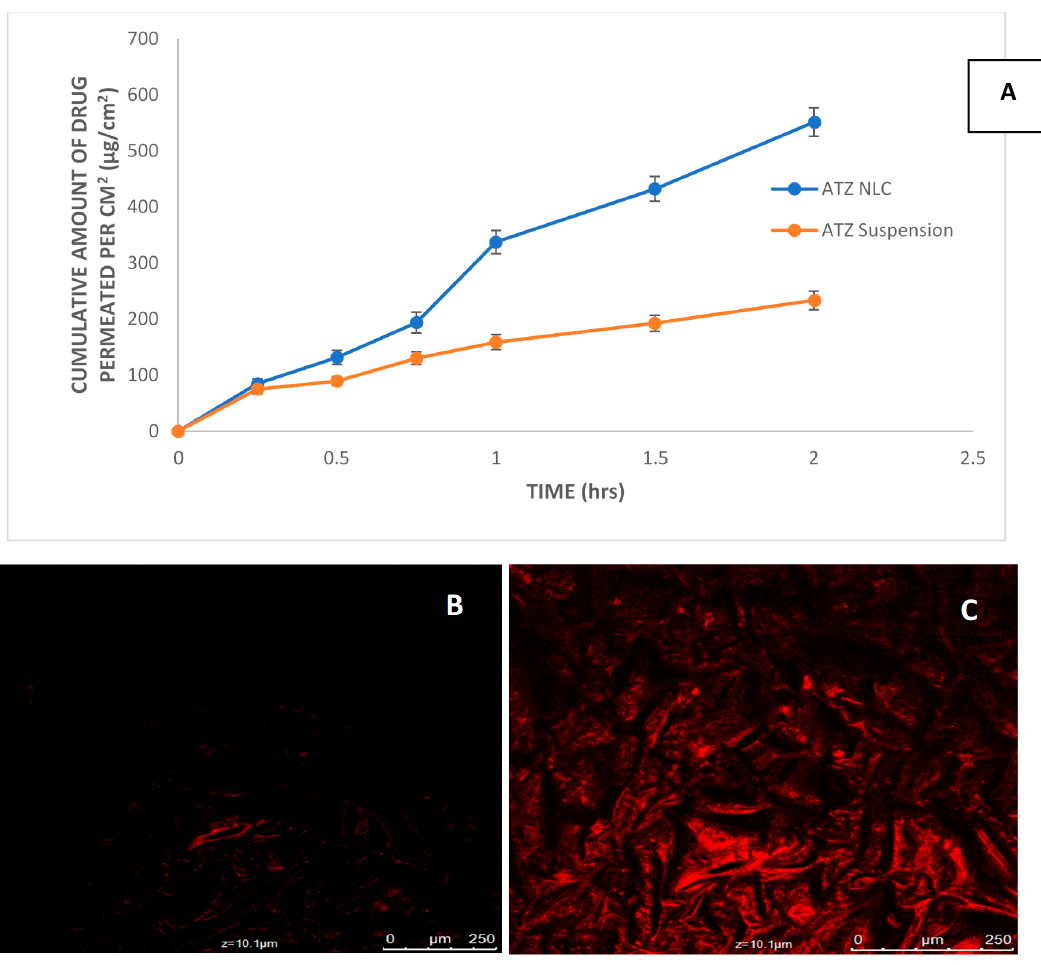
Figure 7. ( A ) Concentration of drug permeated across intestine at different time points. ( B ) Confocal microscopy images of rat brain 2 h after administration of atazanavir suspension. ( C ) Atazanavir NLC.